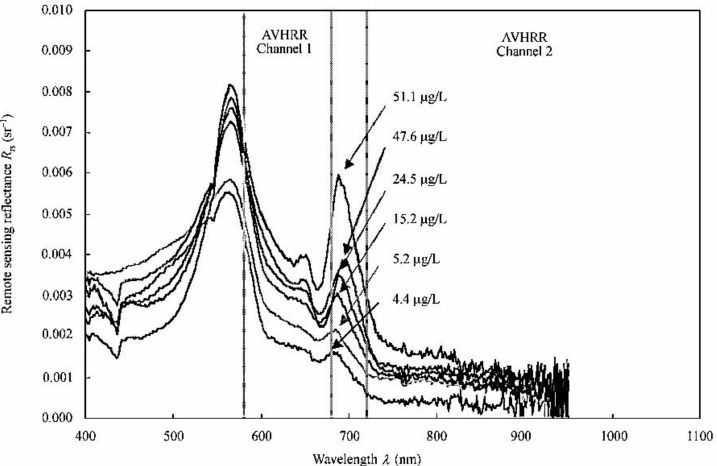
Figure 1. Surface remote sensing reflectance spectrum for the waters with different concentration of chlorophyll a, collected in the study area (119 ◦ 52 (cid:48) –119 ◦ 54 (cid:48) E, 26 ◦ 16 (cid:48) –26 ◦ 19 (cid:48) N) at 10:00–15:40, 2 June 2003. Reprinted with permission from